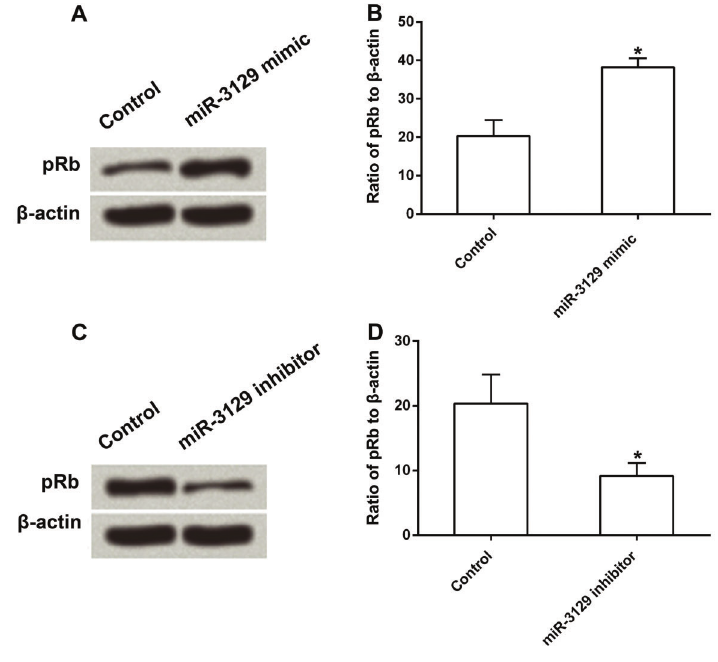
Figure 5. Effects of miR-3129 on pRb expression in SGC7901 cells. A , Western blot and B , RT- qPCR analyses were performed to determine the levels of pRb in miR-3129-overexpressing cells. C , Western blot and D , RT-qPCR analyses were performed to determine the levels of pRb in miR- 3129-suppressing cells. pRb: retinoblastoma pro- tein; RT-qPCR: quantitative real time polymerase